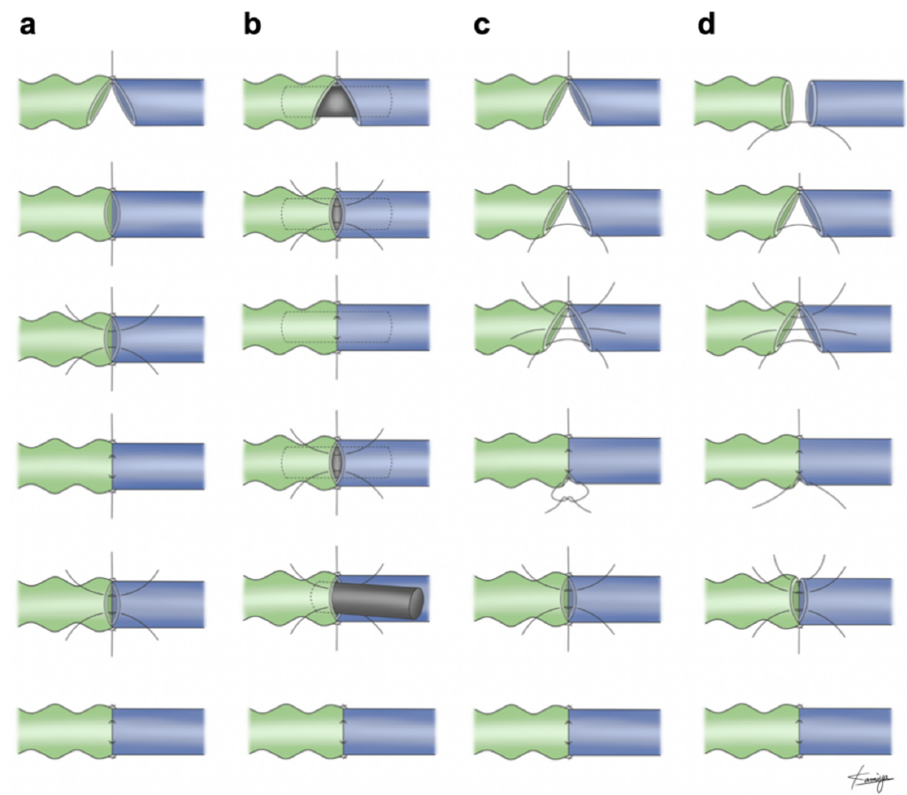
Figure 2. Schema of lymphaticovenular anastomosis: ( a ) the conventional technique, ( b ) the intravascular stent (IVaS) technique, ( c ) the open guide suture technique, ( d ) the suture ‐ stent technique.